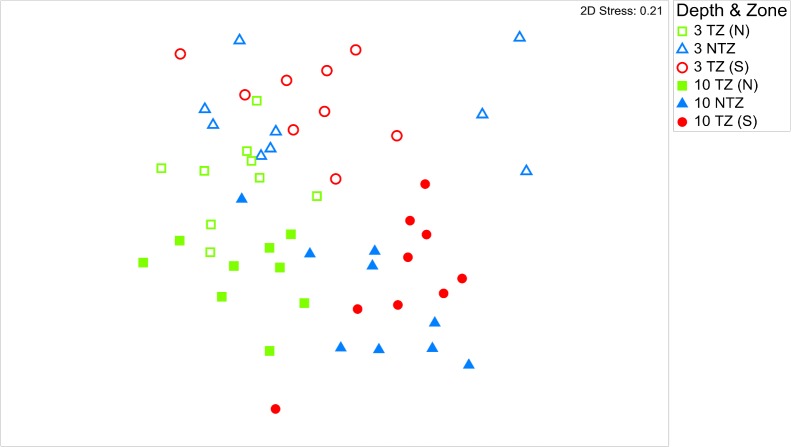
2-D MDS ordination of the fish assemblage at 3 m and 10 m across the three zones; take-zone North TZ (N), the no-take zone NTZ, and take-zone South TZ (S).